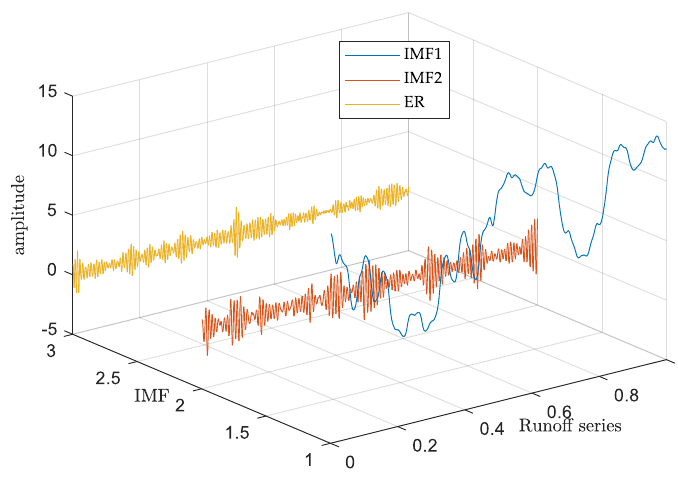
Figure 9. The three modes decomposed by VMD 3D visualization.